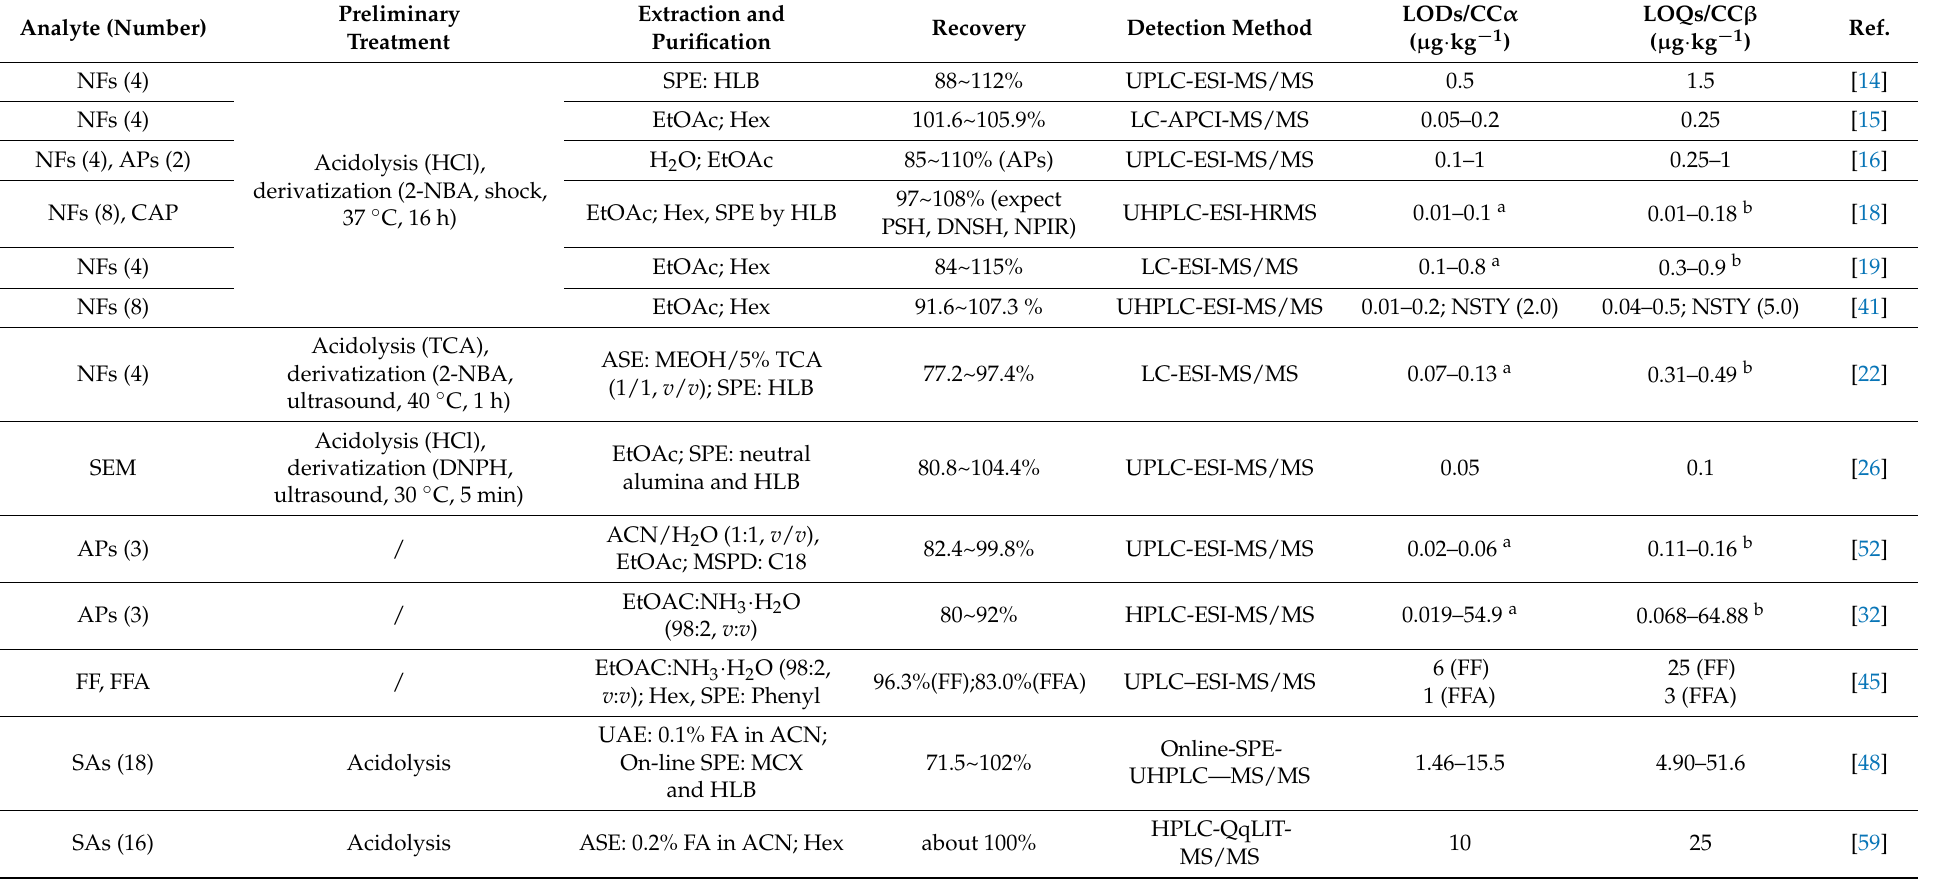
Table 1. The applications of LC/MS for the analysis of antibiotics in aquaculture products during last